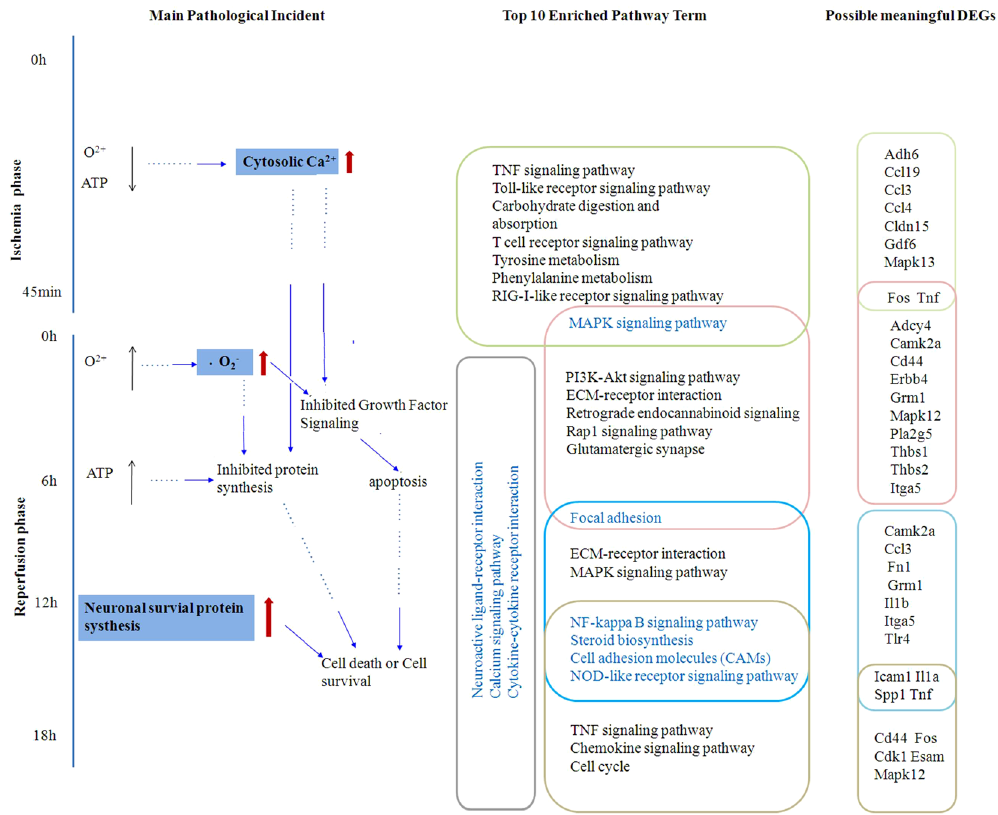
Figure 7. The transition of gene expression patterns in primarily cultured hippocampal neurons after oxygen glucose deprivation (OGD) with reperfusion. Left column, A schematic diagram illustrating major molecular and cellular events upon ischemia and reperfusion. Middle column, Most enriched pathways activated at different time points of ischemia and reperfusion phases. Right column: Validated genes associated with different signaling pathways at different time points of ischemia and reperfusion